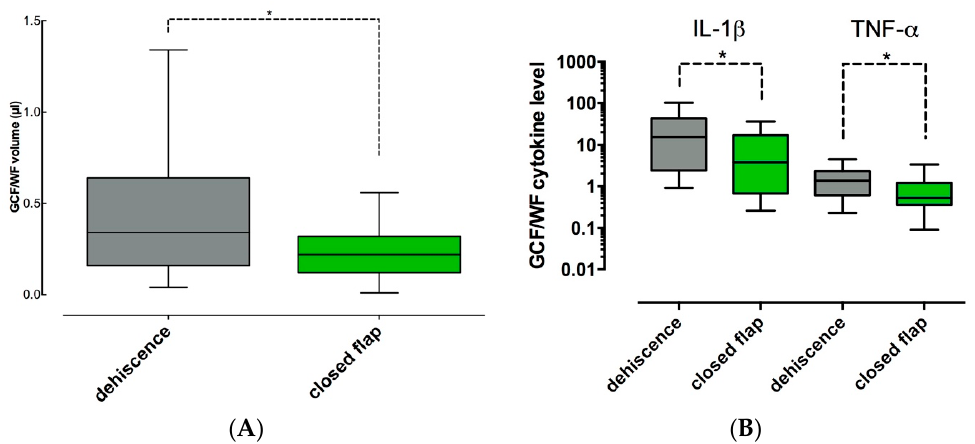
Figure 4. GCF/WF and cytokine levels in sites with/without dehiscence (pooled results for all sites/both groups): ( A ) Significantly higher GCF/WF volume were found in sites with flap dehiscence, when compared to closed flaps (*: p < 0.05); ( B ) Significantly higher total amounts/sample of IL-1 β and TNF- α were found in sites with flap dehiscence, when compared to closed flaps (*: p < 0.05). Dehiscence: grey, closed flap: green.